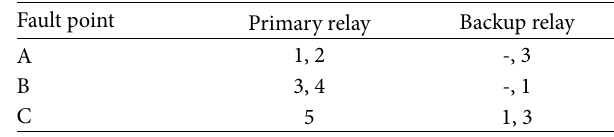
Table 11: Primary and backup relationships of the relay.